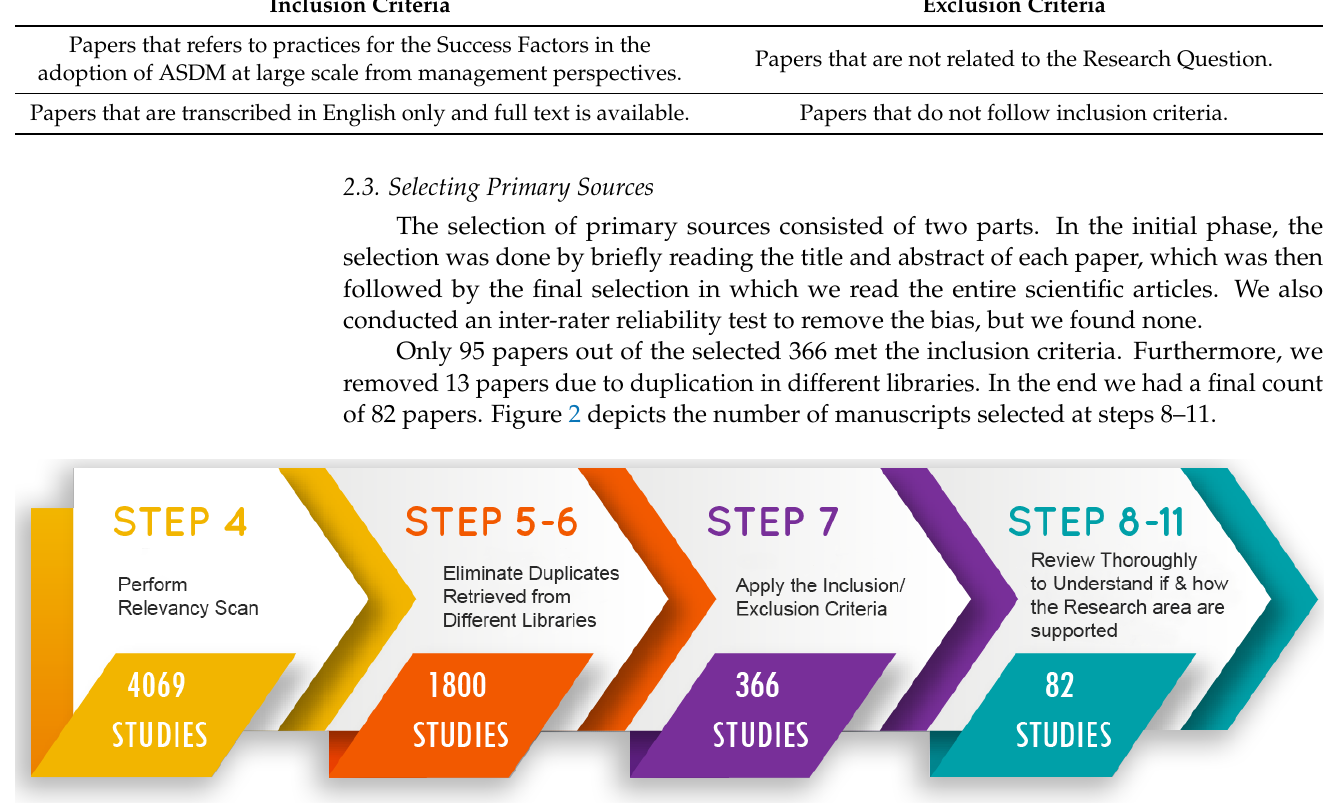
Figure 2. Publication selection